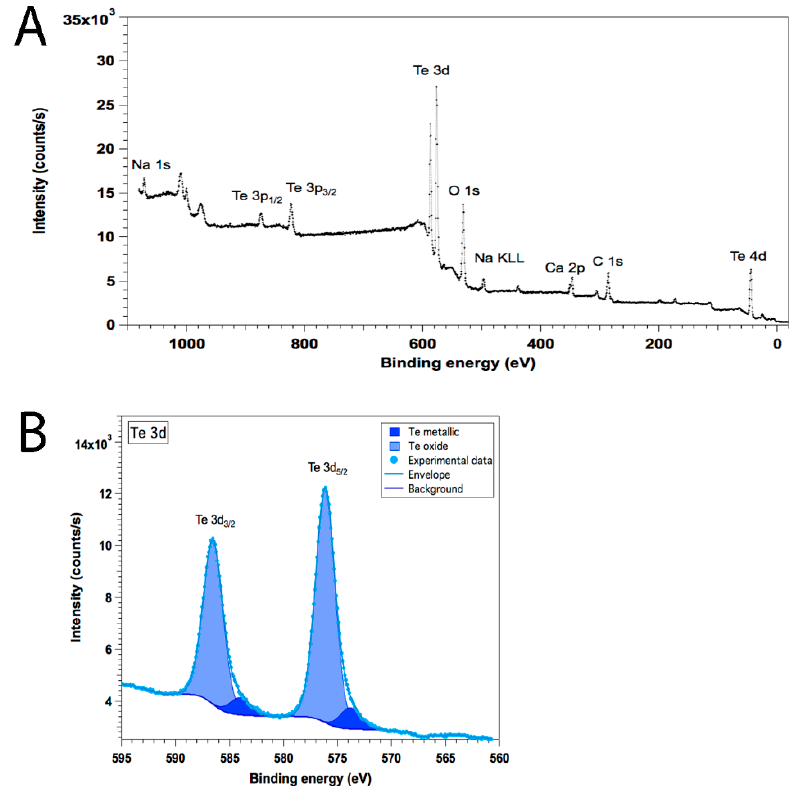
Figure 4. Broad scan XPS spectrum ( A ) and Te 3d XPS core level spectrum with the corresponding metallic and oxide components ( B ).